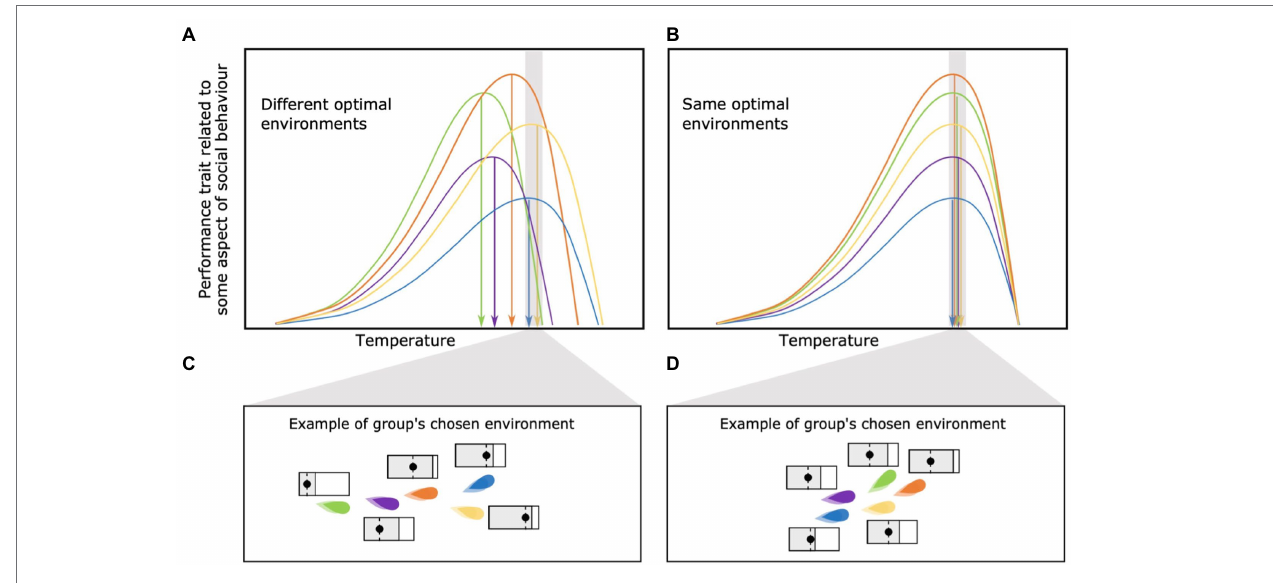
FIGURE 5 | (A) Among-individual differences in optimal environments vs. (B) equal optimal environment among individuals belonging the same social group. One of the consequences of among-individual differences in optimal environments is that individuals may fit into different social “niches,” each with a different behavioral capacity and expression, depending on the physiological constraints they end up facing within the group’s chosen environment (C) . On the other hand, an similar optimal environments may lead to behavioral conformity among individuals (D) .